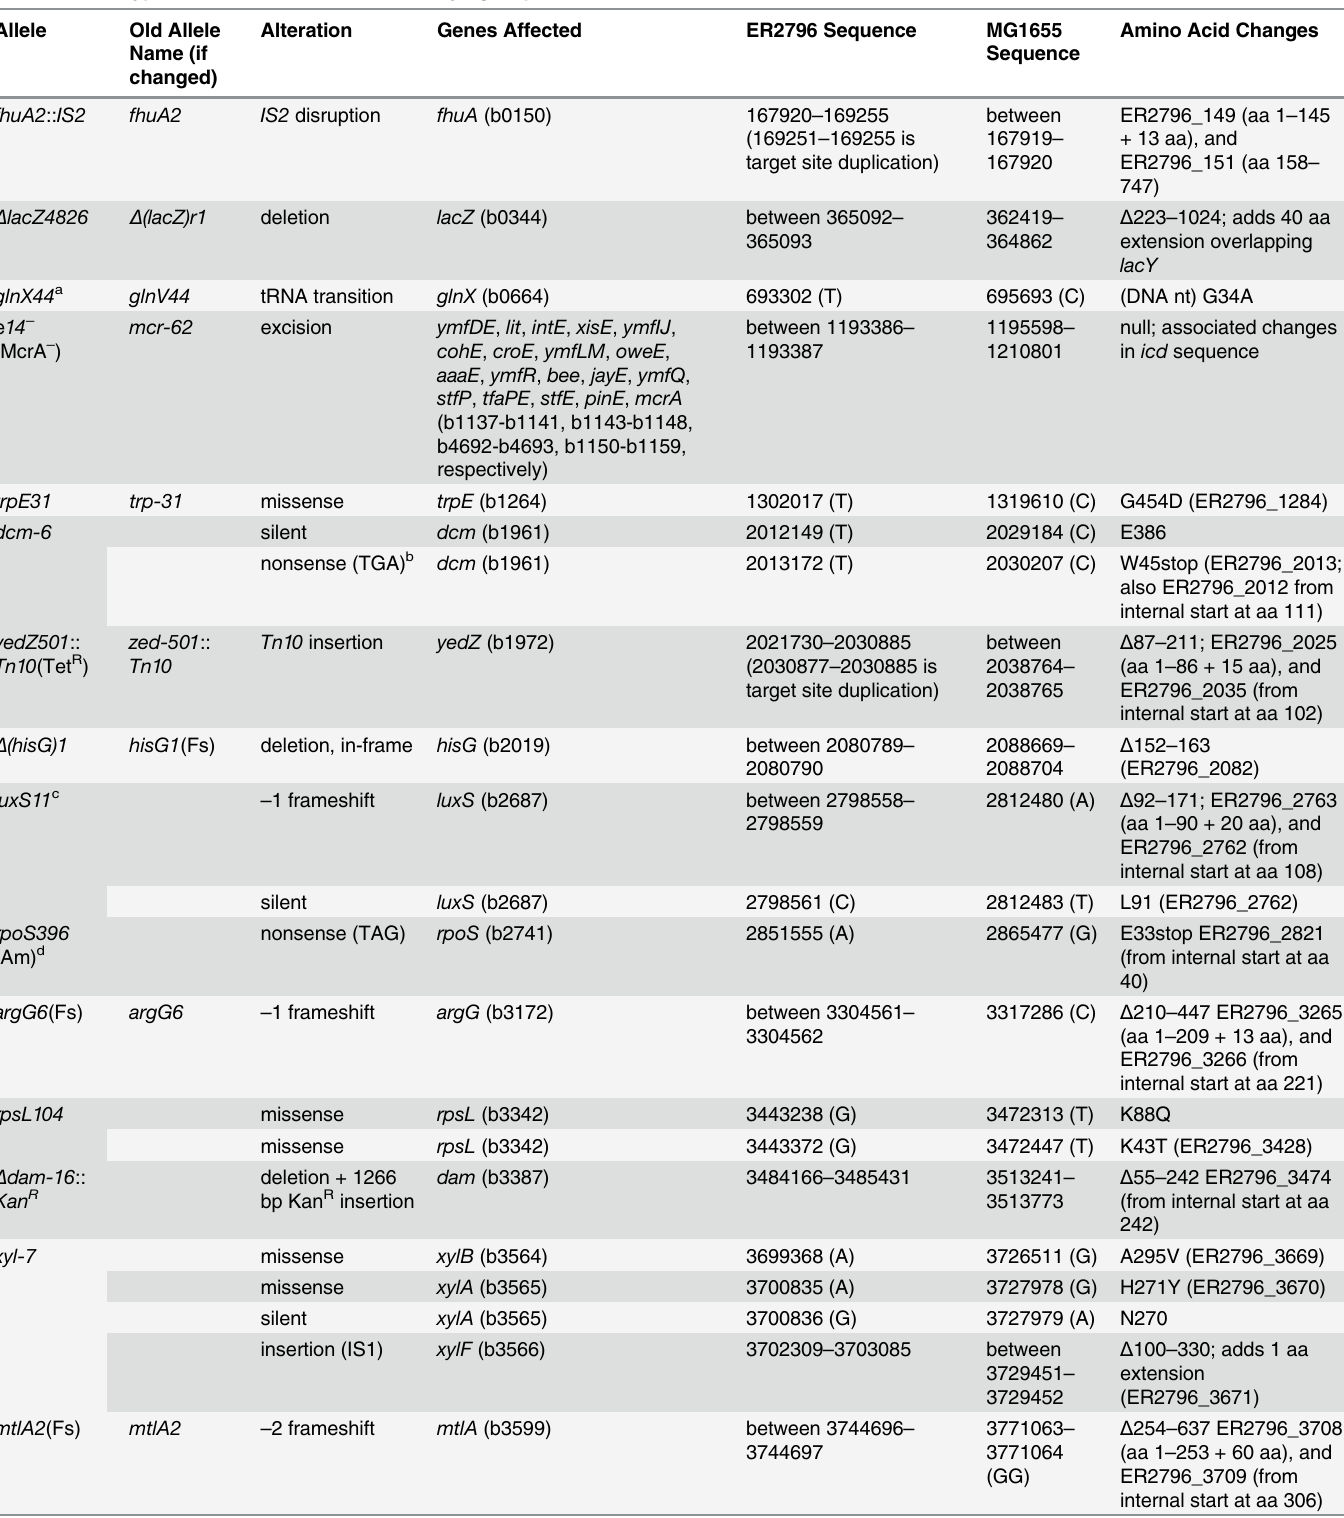
Table 3. Genotype markers in ER2796 and underlying sequence